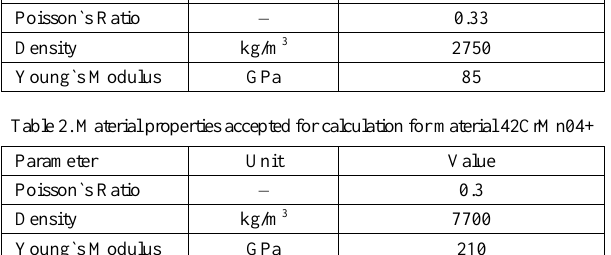
Table 1. Material properties accepted for calculation for material M174 + Parameter